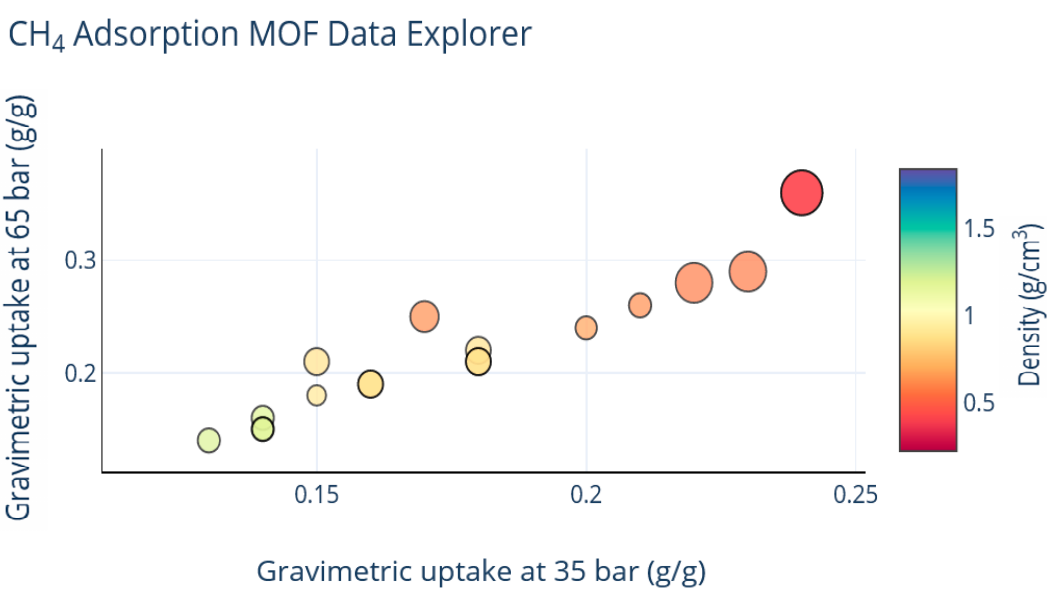
Figure 4. QSPR for CH 4 storage in MOFs. CH 4 gravimetric uptake at 298 K and 65 bar and gravimetric uptake at 298 K and 35 bar. Each point represents a MOF. The data points are color-coded for the density of the MOF, and the diameter of each circle represents the largest cavity diameter (LCD) of the MOF.